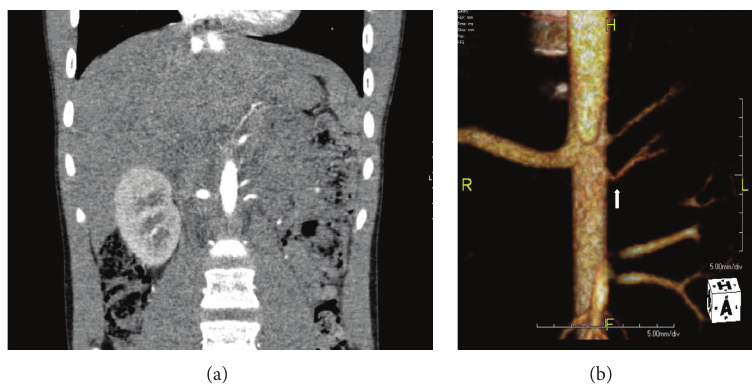
Figure 5: (a) Abdominal CTA coronal reformation and (b) three-dimensional reconstruction showing the left kidney supplied by two hypo- plastic renal arteries originating from the aorta. The origin of the inferior left renal artery has a focal area of stenosis proximally, depicted by the white